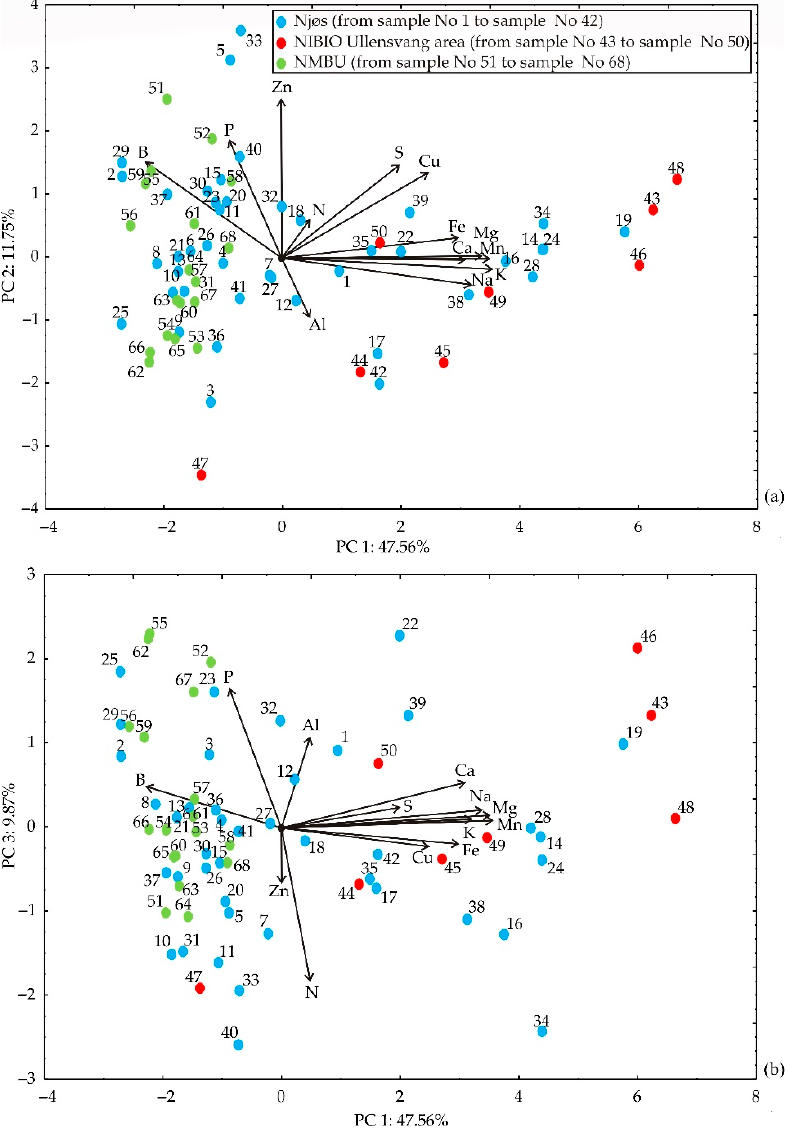
Figure 2. PCA ordination of element content variables: ( a ) projection in the PC1-PC2 plane; ( b ) pro- jection in the PC1-PC3 plane.